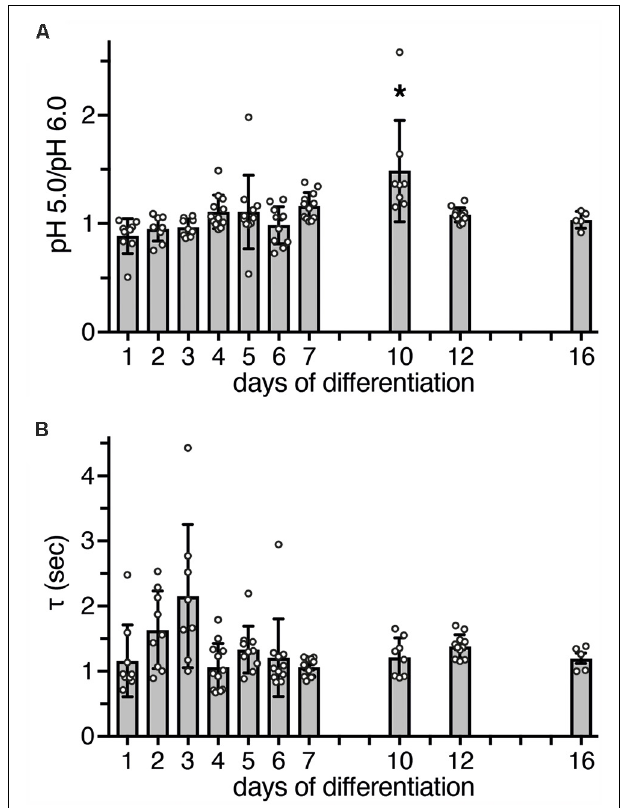
FIGURE 4 | Functional characteristics of ASIC currents between d1 and d16. (A) Bars represent the peak amplitude elicited by pH 5.0 divided by the peak amplitude elicited by pH 6.0. Currents were elicited by a pH drop from 7.4 to 6.0 or 5.0, respectively, for 10 s. The ratio at d10 was significantly different from d1 ( p < 0.0001), d2 ( p = 0.001), d3 ( p = 0.001), and d6 ( p = 0.011, Kruskal-Wallis test followed by Dunn’s test). * p < 0.05. (B) Bars represent τ des of ASIC currents at different days of differentiation; p > 0.05 on all days (Kruskal-Wallis test followed by Dunn’s test). n = 5–12 from two independent